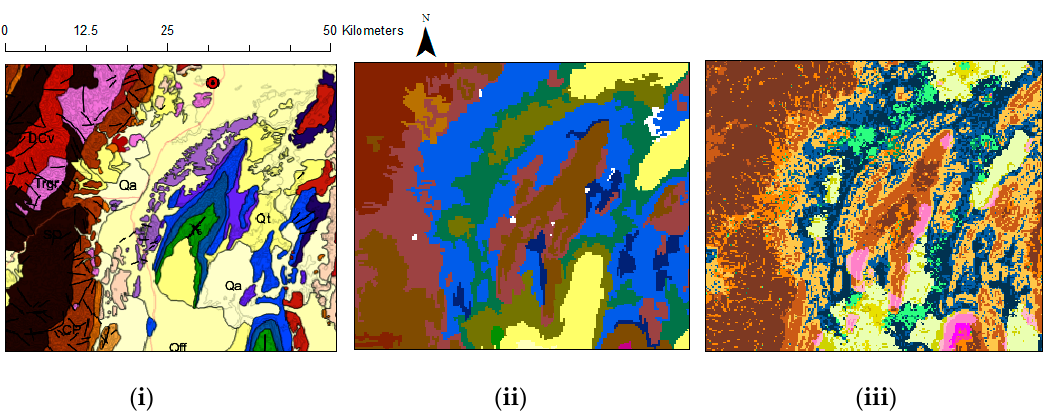
Figure 10. ( i ) Geology map of Thailand [61]: the geological units are fluvial deposit (flood plain [Qff]), terrace and colluvium [Qt], alluvium (Qa), rhyolite [PTrv], semiconsolidate [Tmm], and granite [Trgr]; ( ii ) OBC geomorphology map from Iwahashi et al. [50]; and ( iii ) classified PBC geomorphology map. The geomorphological units for( ii , iii ) are based on the descriptions in Figure 4.